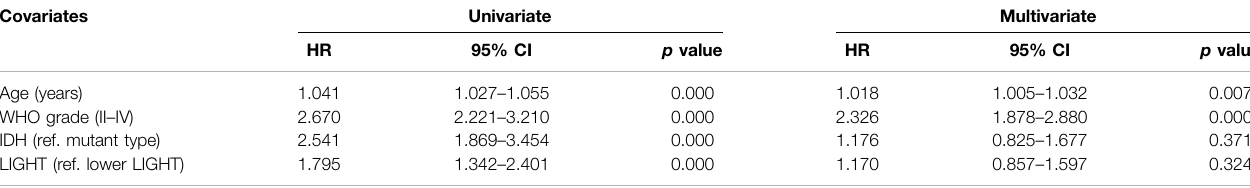
TABLE 1 | Cox logistic regression analysis of overall survival in the CGGA_301 cohort. Covariates